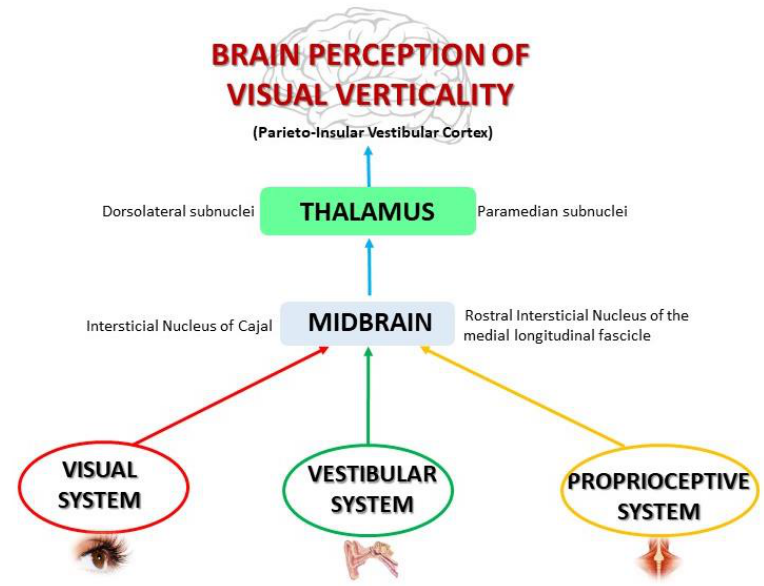
Figure 1. Visual, vestibular, and proprioceptive contributions to build the sense of